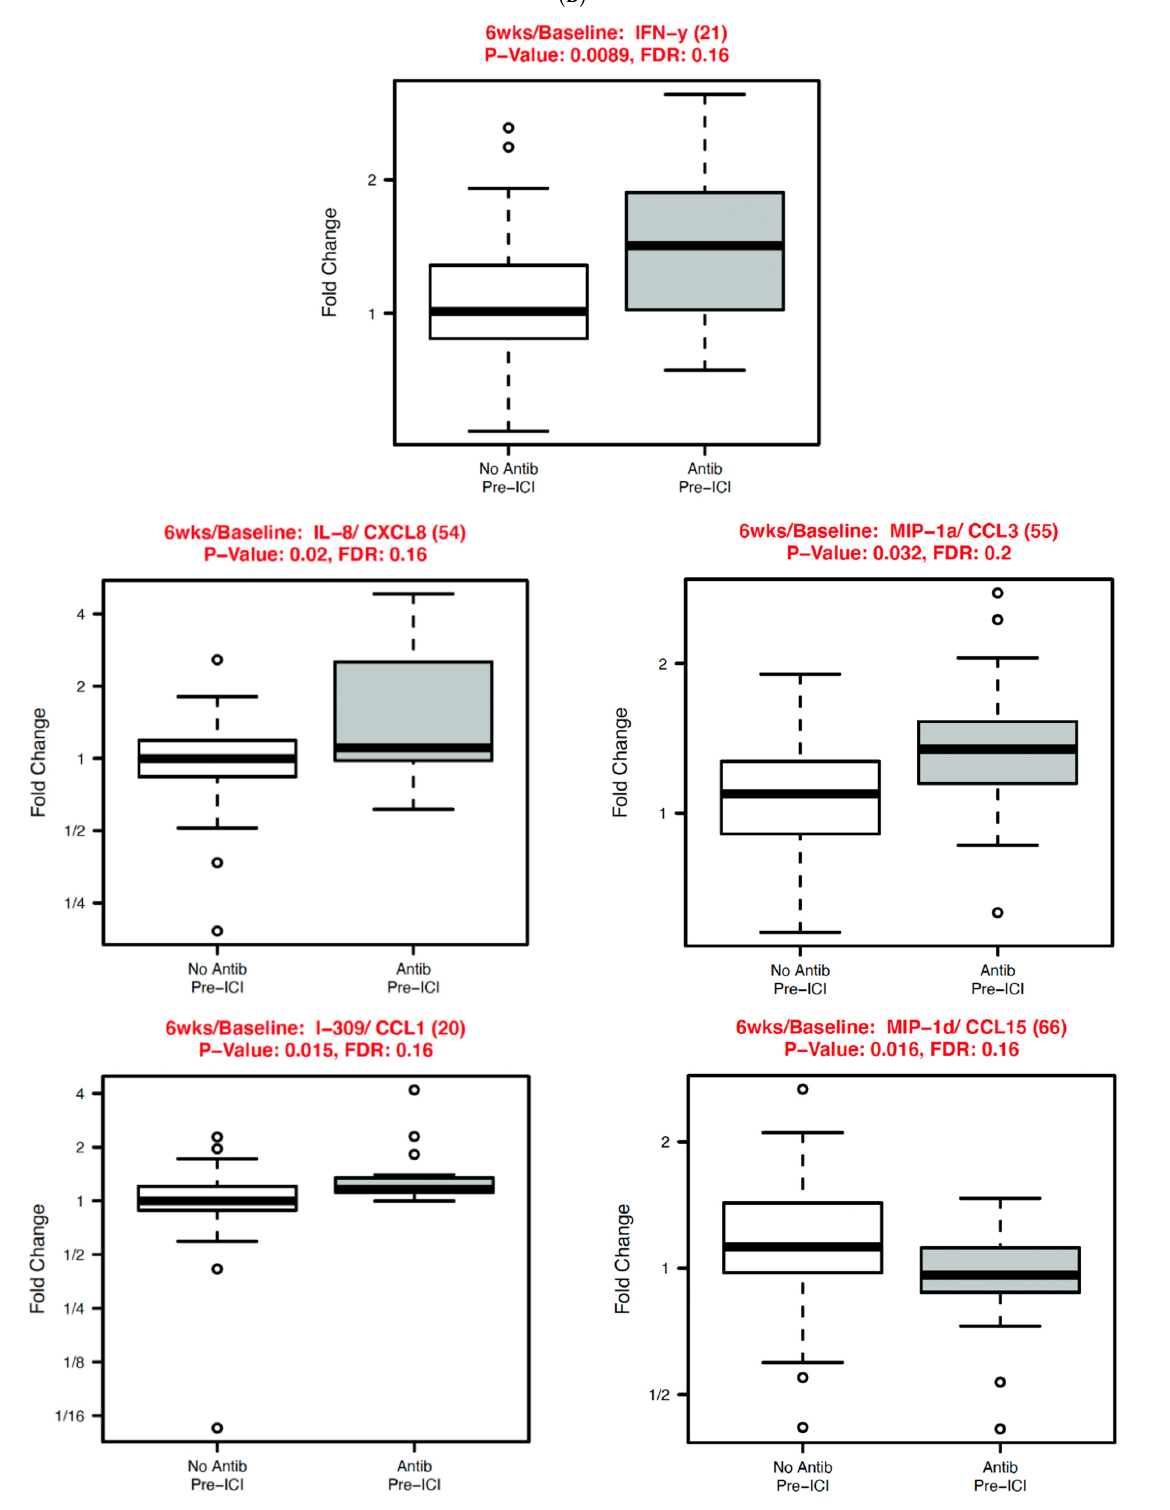
Figure 5. Systemic immune parameters with significant differences ( p < 0.05 and FDR < 0.2) according to antibiotic exposure before ICI initiation in non-small cell lung cancer cases. ( A ) 6 weeks; ( B ) 6 weeks/baseline.